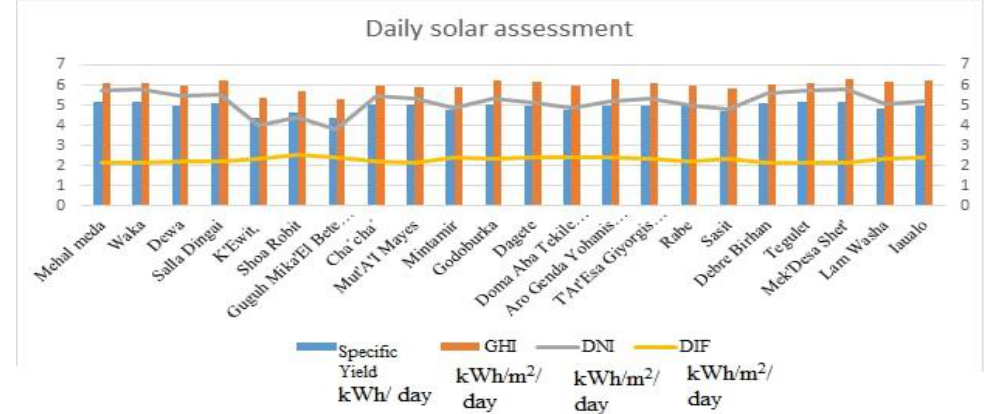
Figure 3. Daily solar assessment atdifferent locations. Table 2. Cumulative solar DNI in kWh/m 2 per year and remarks [34].